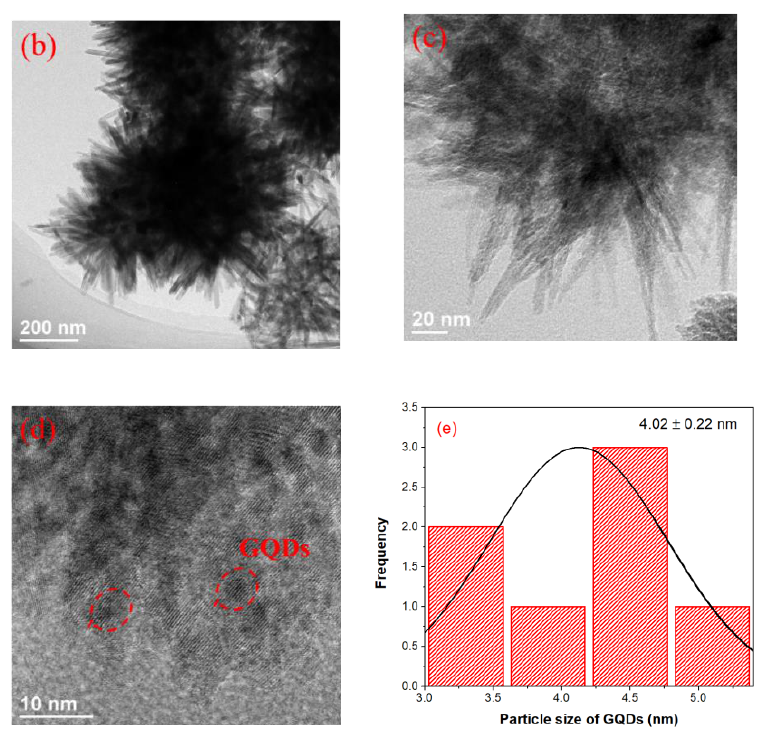
Figure 1. X-ray diffraction spectra ( a ), TEM images of GQDs/ α -FeOOH ( b – d ), (GQDs corresponding to the red circled area), and ( e ) particle size distribution histogram of GQDs.